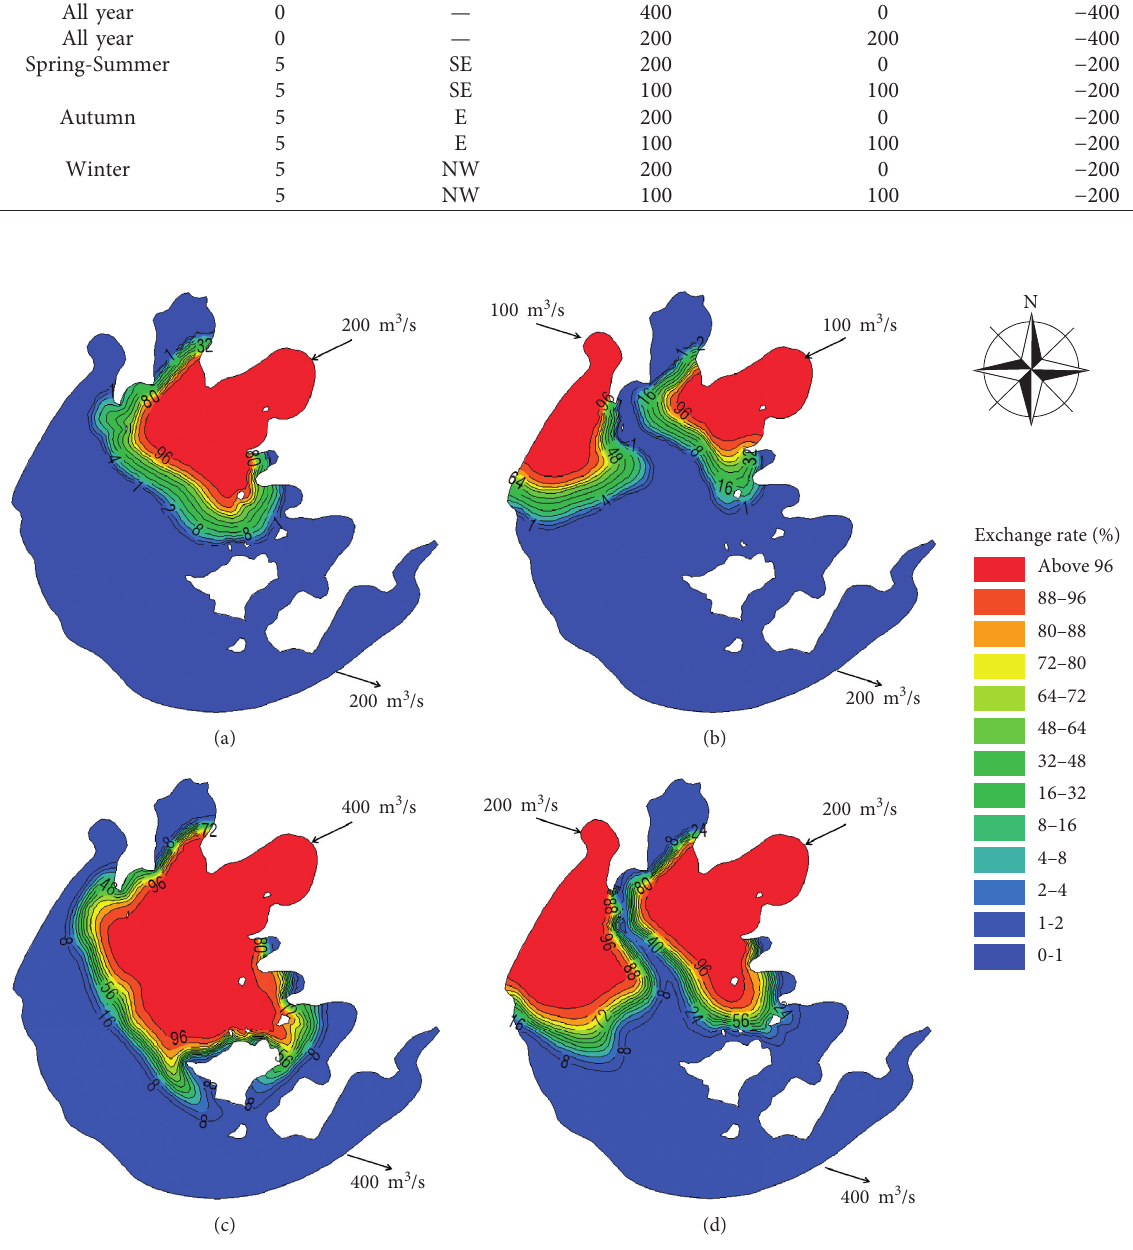
Figure 6: Simulated water body exchange rates under operating modes (a)–(d) as described in the main